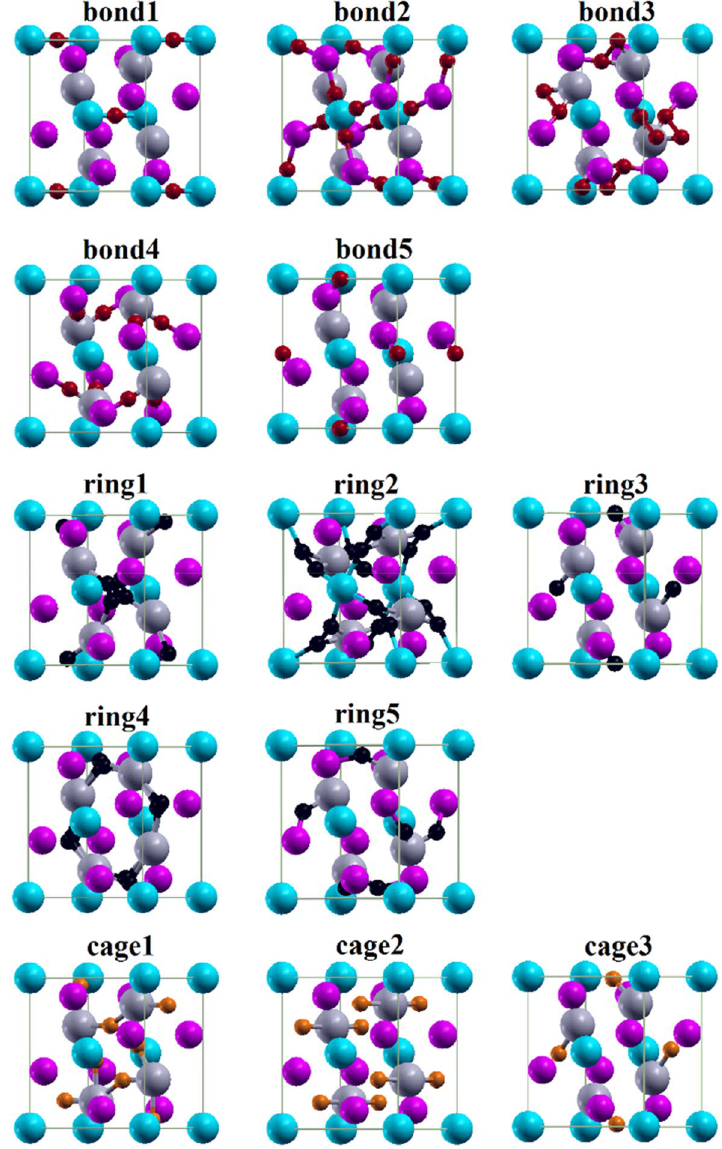
Figure 6. Bond CPs (red spheres), ring CPs (black spheres), and cage CPs (orange spheres). Gray, blue, and purple spheres represent the RE, Mg, and Ge atoms,